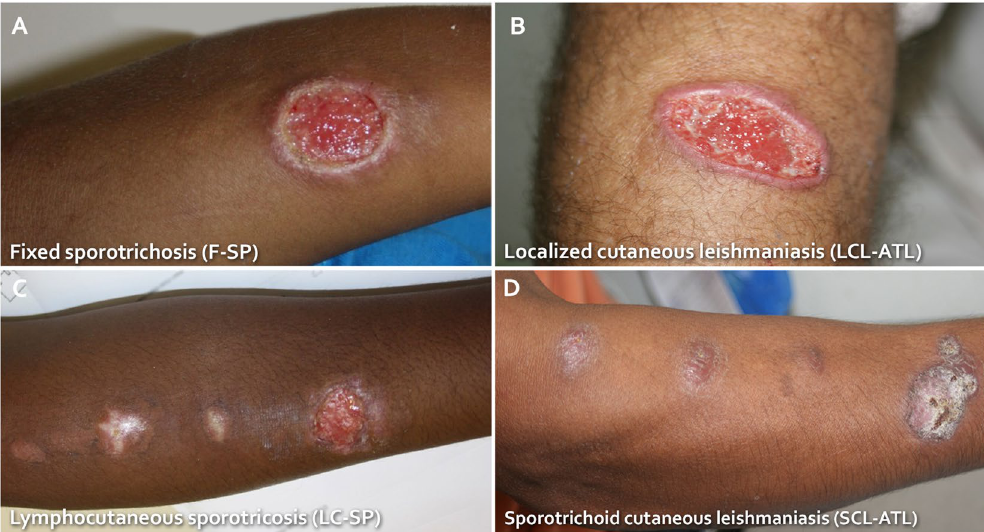
Figure 1. Comparison of the clinical presentations of patients with ( A ) a fixed form of sporotrichosis (F-SP), ( B ) localized cutaneous leishmaniasis (LCL-ATL), ( C ) lymphocutaneous (LC-SP) form of sporotrichosis and ( D ) sporotrichoid cutaneous leishmaniasis (SCL-ATL). Note the similarities between the different clinical forms of sporotrichosis and ATL.